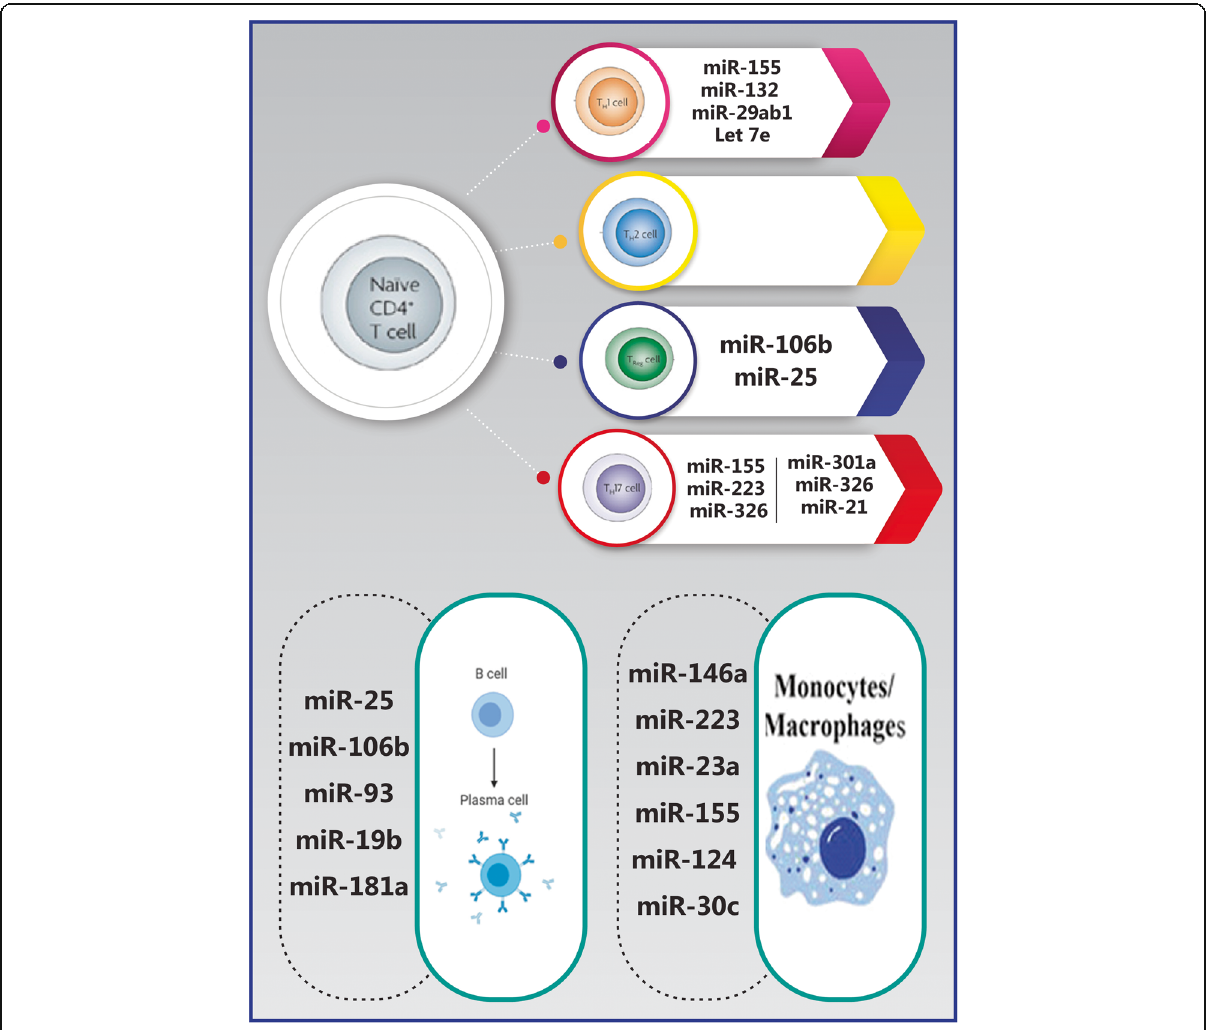
Fig. 5 Micro RNAs dysregulation in immune compartment of multiple sclerosis. Dysregulation of different MiRNAs were reported to control the inflammatory activity of various immune cells (Th1, Treg, Th17, macrophages, and B